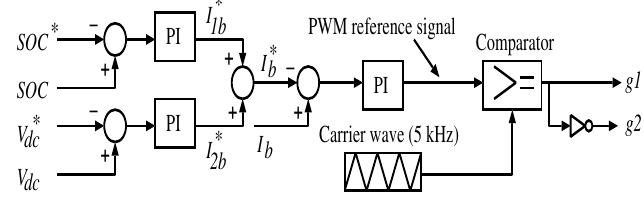
Figure 7. Battery control system in normal